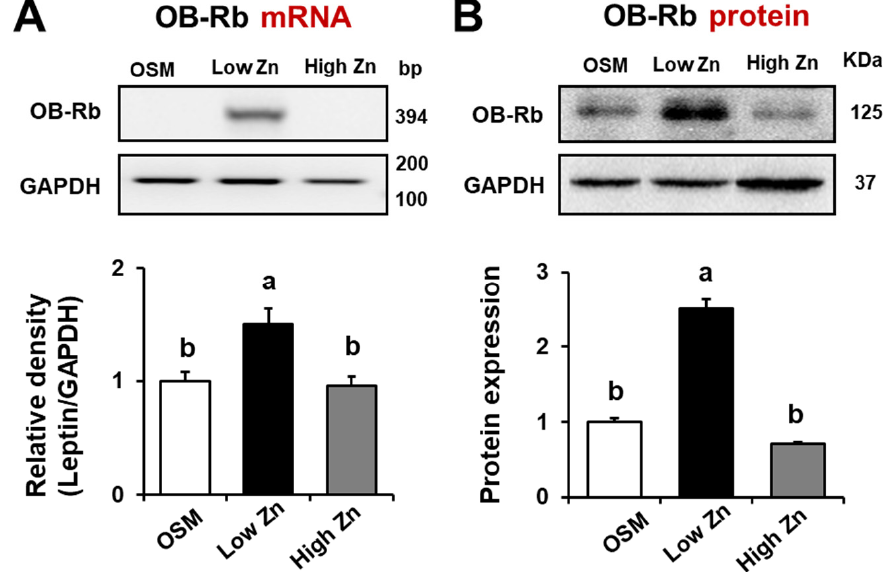
Figure 3. Effects of low Zn on mRNA and protein expression of the OB-Rb in MC3T3-E1 cells. OSM is the normal osteogenic differentiation medium without Zn chelator, 5 µ M TPEN. 1 µ M (low Zn) and 15 µ M (high Zn) are the media Zn added as designated with5 µ M TPEN. ( A , B ) mRNA and protein expression of the long form leptin receptor (OB-Rb) in MC3T3-E1 cells treated with either low or high Zn were analyzed by RT-qPCR and western blotting. GAPDH was utilized as loading control for protein normalization. Data represent means ± SEM. One-way ANOVA model was used to analyze the dataset. Once significance is noted, Tukey’s HSD method was further applied to find significances between groups. Groups with different superscript letters are significantly different from one another, p < 0.05.